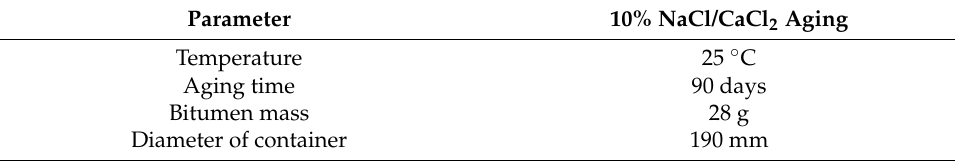
Table 3. Parameters for salt solution